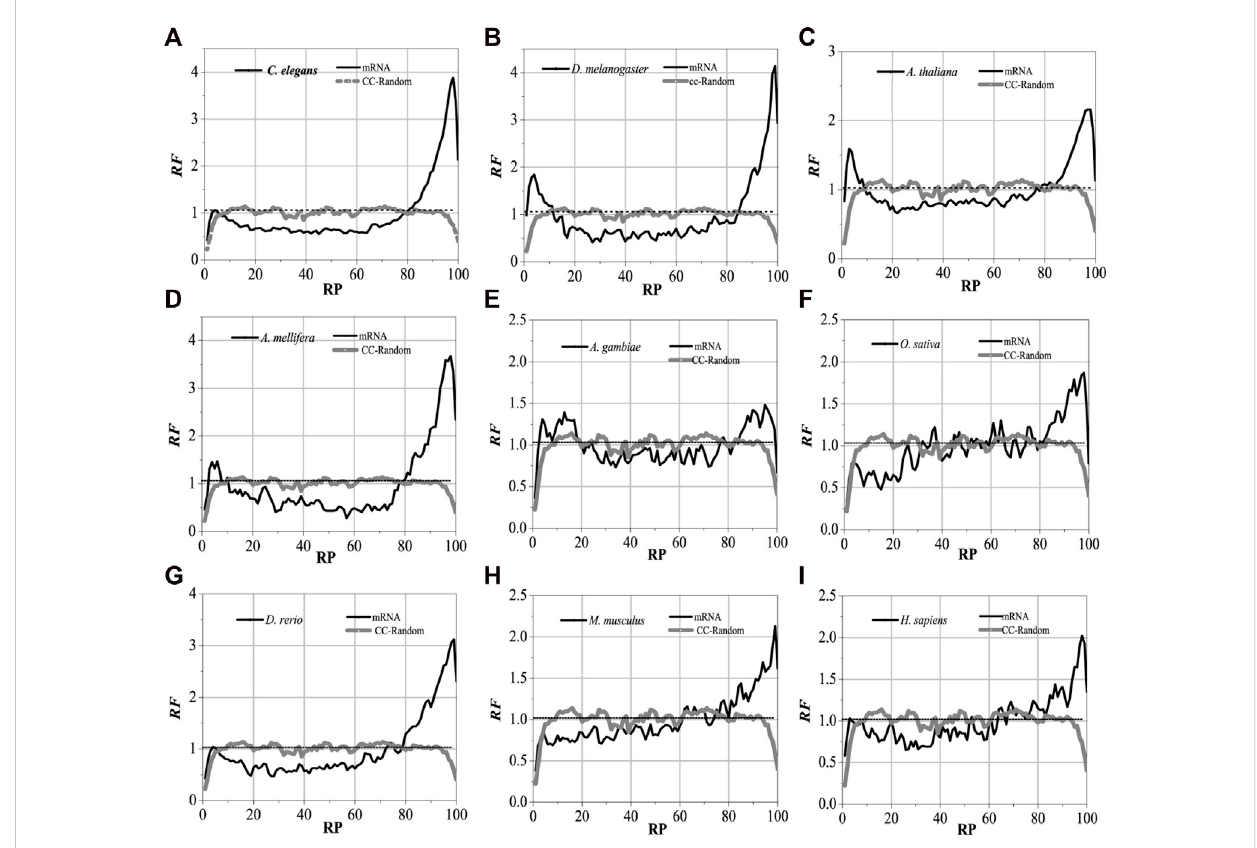
FIGURE 2 RF distributions of mRNA. The X-axis is the relative position of mRNA and the Y-axis represents the RF values. CC-Random means the local alignment were done between the component constraint random mRNA and their own component constraint random introns. RF = 1 represents the average value of relative match frequencies